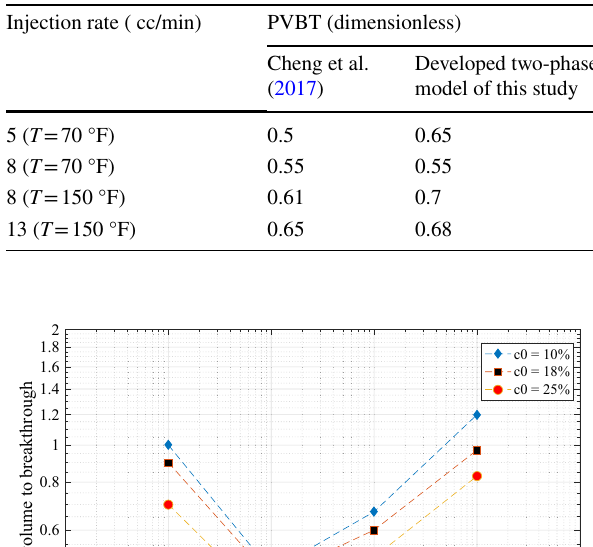
Table 3 Comparison of the results of this study and experiments by Fredd et al. (1998)